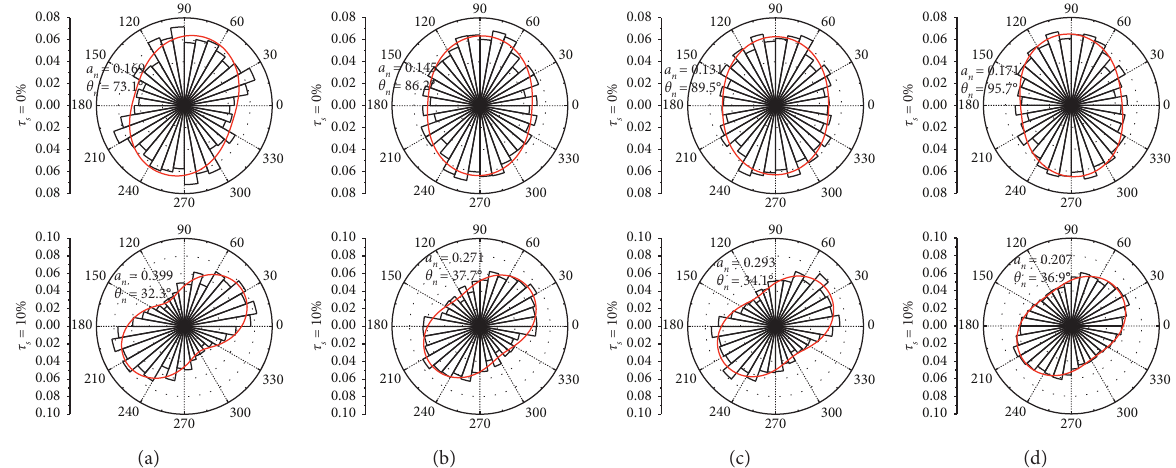
Figure 8: Rose diagrams of contact normal force distribution at ε